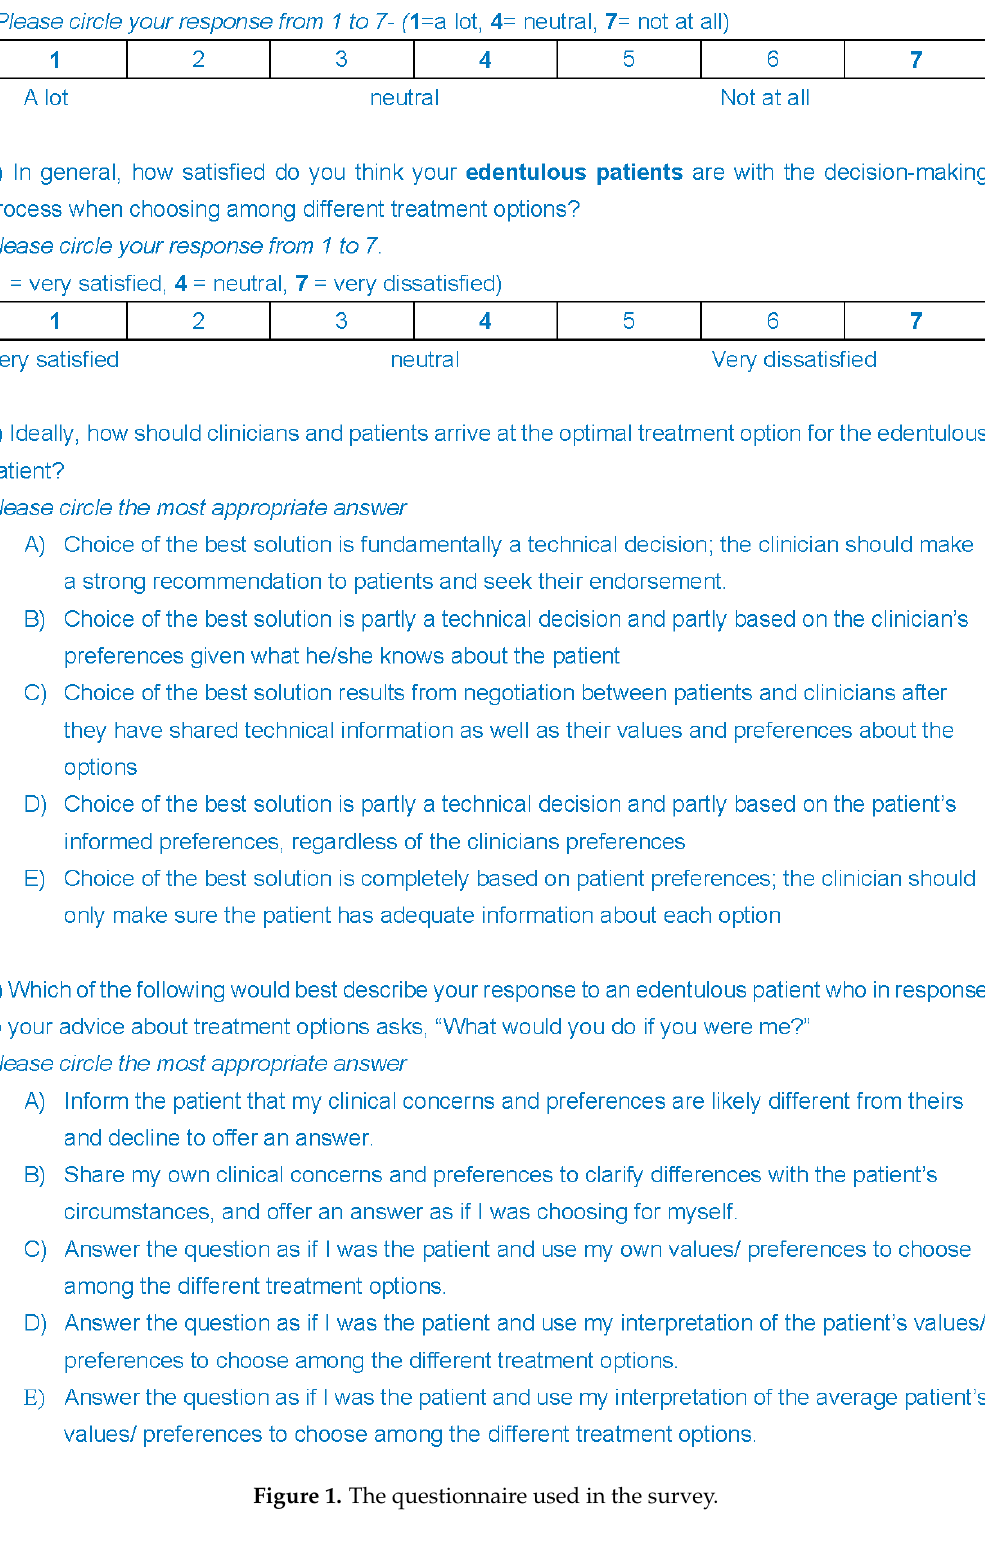
Figure 1. The questionnaire used in the survey.